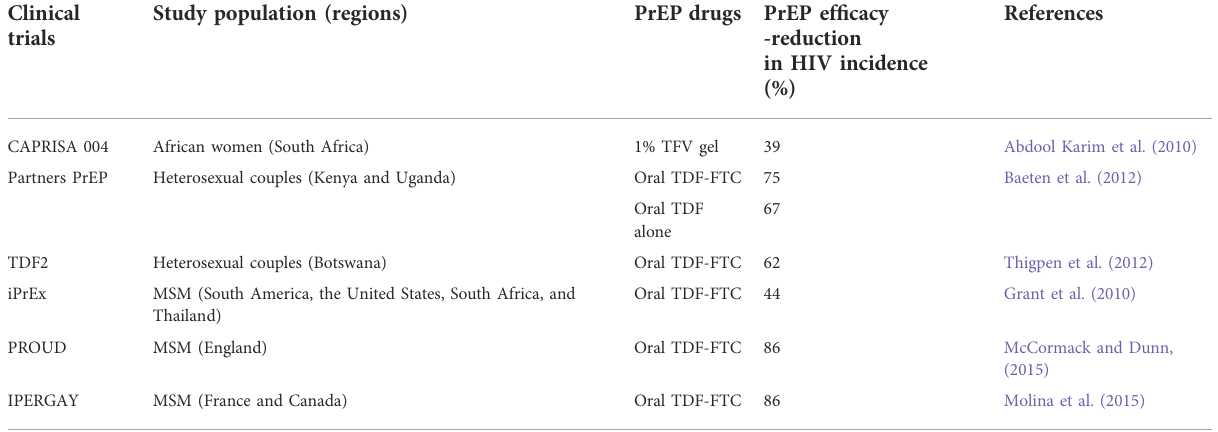
TABLE 1 PrEP clinical trials demonstrating various ef fi cacies in high-risk populations from different